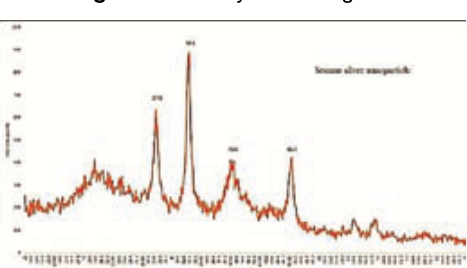
Fig. 6. EDS analysis of S-AgNPs